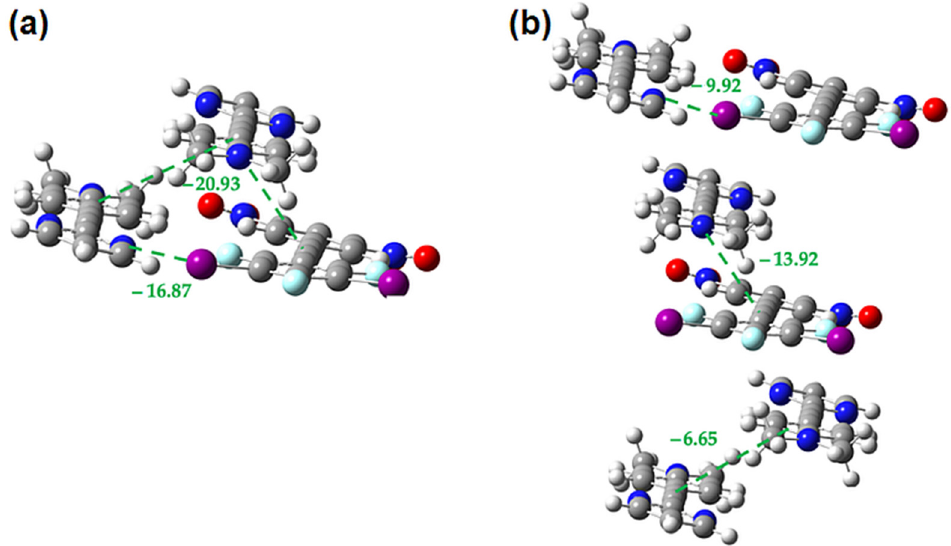
Figure 22. M062X-D3/DGDZVP interaction energies (in kcal/mol) in the 2 • 3 cocrystal for the interplay between the offset 2-3 π -stacking and the linear halogen bond ( a ) within trimer ( b ) in the isolated dimers.